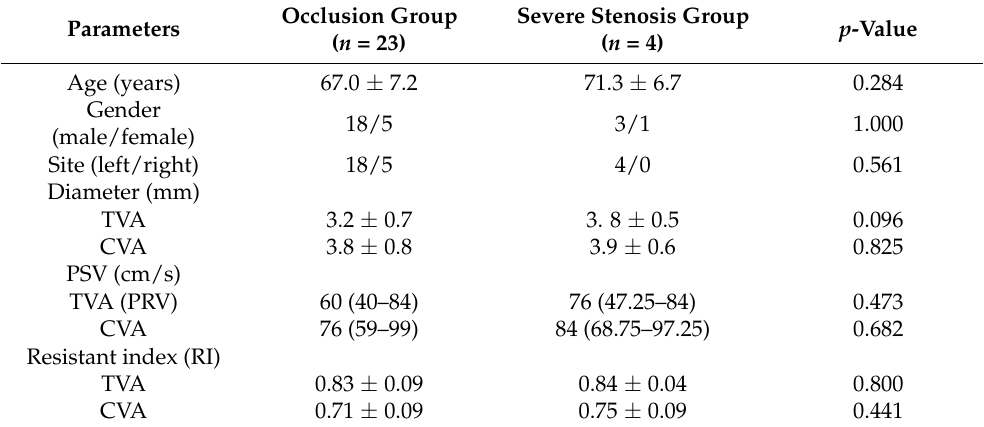
Table 4. Parameters of VA ultrasound in 27 patients with CCRF in the VA between the SA occlusion group and the severe stenosis group.